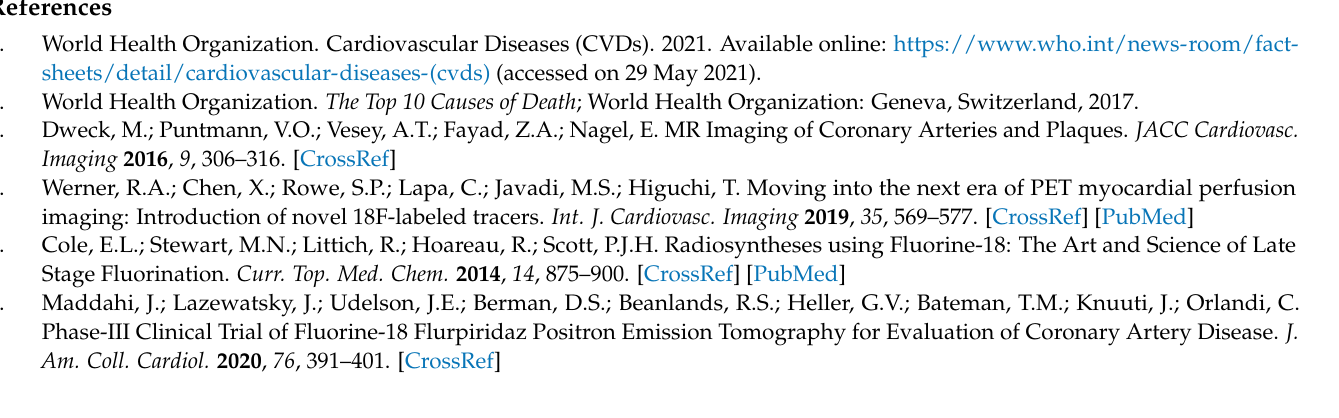
Figure S2: Summary of the expression data between MI and control